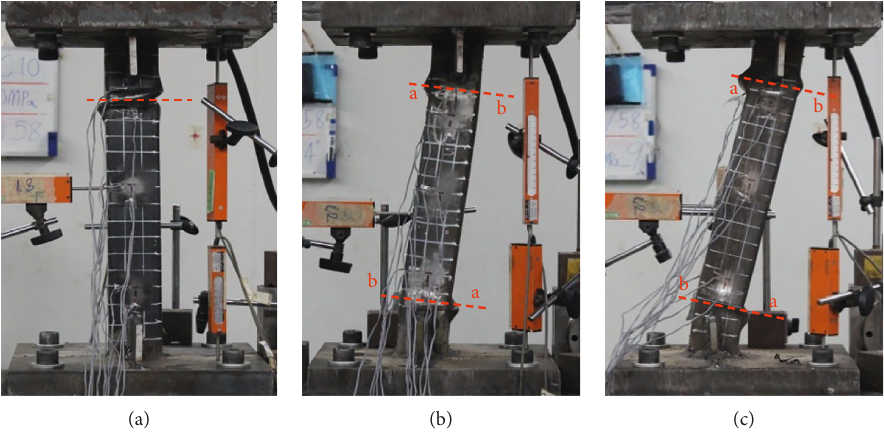
Figure 6: Failure pattern of T3.0C20 series samples. (a) T3.0C20A0. (b) T3.0C20A4. (c)